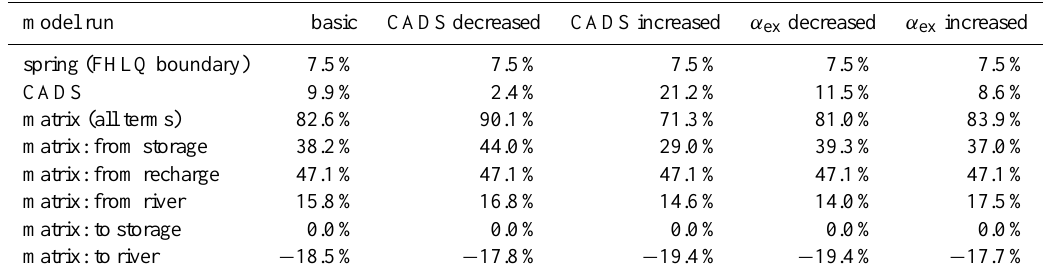
Table 1. Water budget terms for CFPM1 demonstrating the origin of pumped water. All terms are computed based on average values for period